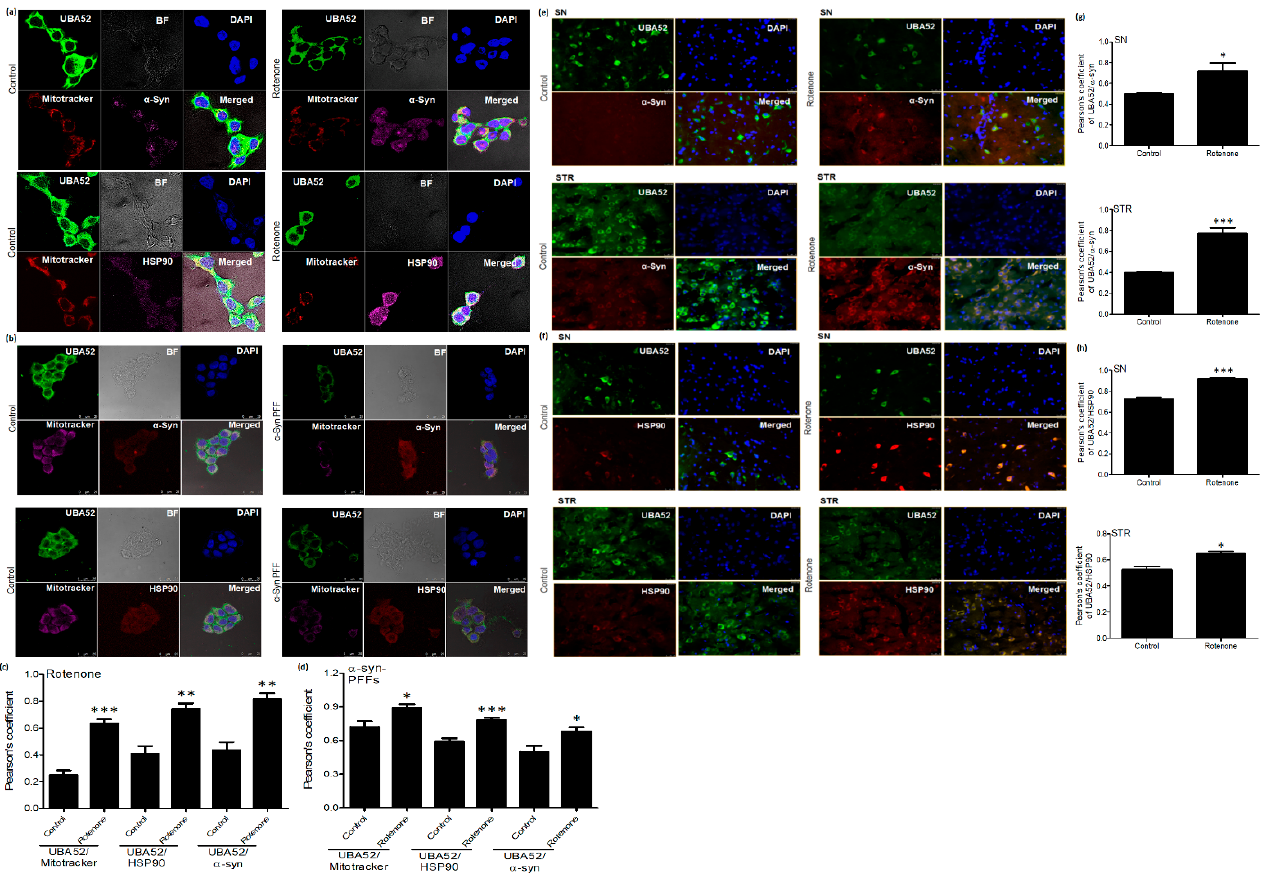
Figure 6. UBA52 co-localizes with α -syn and HSP90. ( a , c ) Confocal microscopy images and Pearson’s correlation coefficient analysis represent the co-localization of UBA52 and α -syn/HSP90 in control and rotenone-treated SH-SY5Y cells along with the mitotracker deep red (647 nm) and DAPI (405 nm) representing the mitochondrion and nucleus, respectively, Alexa fluor: Green-488, Pink-546; n exp = 3. ( b , d ) Confocal microscopy images and Pearson’s correlation coefficient analysis represent the co-localization of UBA52 (Alexa fluor Green-488) and α -syn/HSP90 (Alexa fluor Red-546) in control and human recombinant α -synuclein preformed fibrils (PFFs)-induced SH-SY5Y cells along with the mitotracker deep red (647 nm) and DAPI (405 nm) representing the mitochondrion and nucleus, respectively, scale bar—25 μ m; n exp = 2. ( e , g ) Fluorescent images of rat brain sections representing the co-localization of UBA52 (Alexa fluor Green-488) and α -syn (Alexa fluor Red-546) in both SN and STR regions; n exp = 3. ( f , h ) Fluorescent images of rat brain sections representing the co-localization of UBA52 (Alexa fluor Green-488) and HSP90 (Alexa fluor Red-546) in both SN and STR regions; n exp = 3. Quantifications are the mean and SEM of at least three independent experiments, and statistical analyses were performed using Student’s t -test. ( c ). * p < 0.05, ** p < 0.01, *** p < 0.001 control vs. treated.